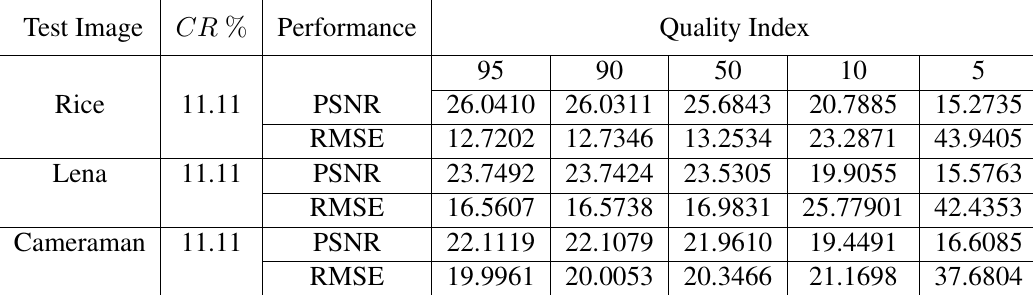
Table 2: Compression performance at different reconstruction qualities in the case of 3 × 3